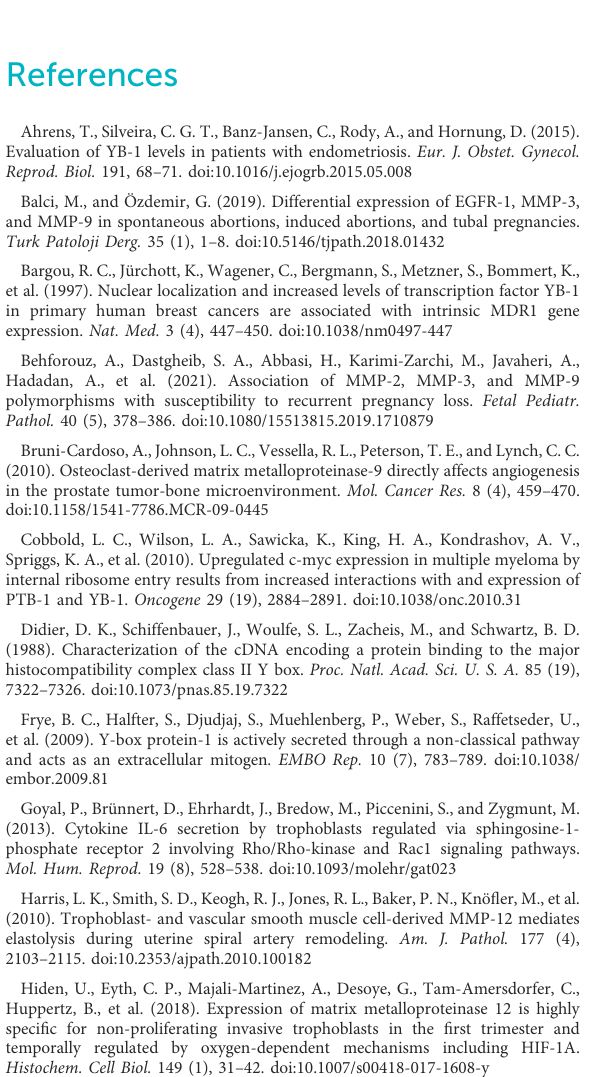
SUPPLEMENTARY TABLE S1 List of primers used in the present study. UPL, Universal Probe Library